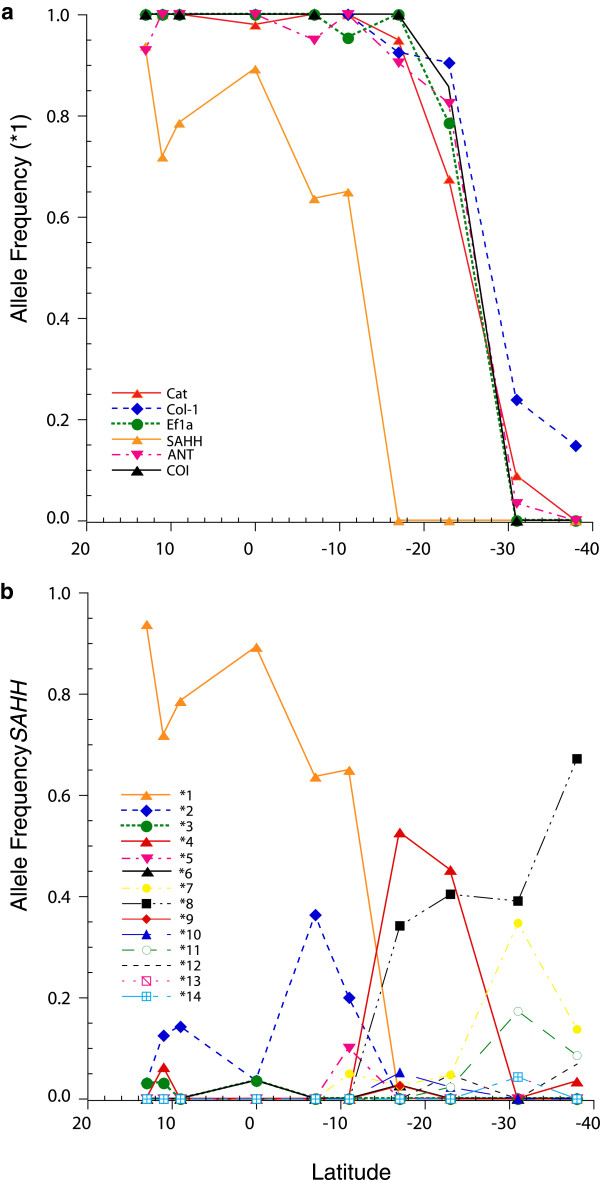
Latitudinal clines.(a) Step-clines for the predominant northern allele (haplotype: *1) at six loci toward southern direction from left to right (b) Allelic frequencies of SAHH alleles.